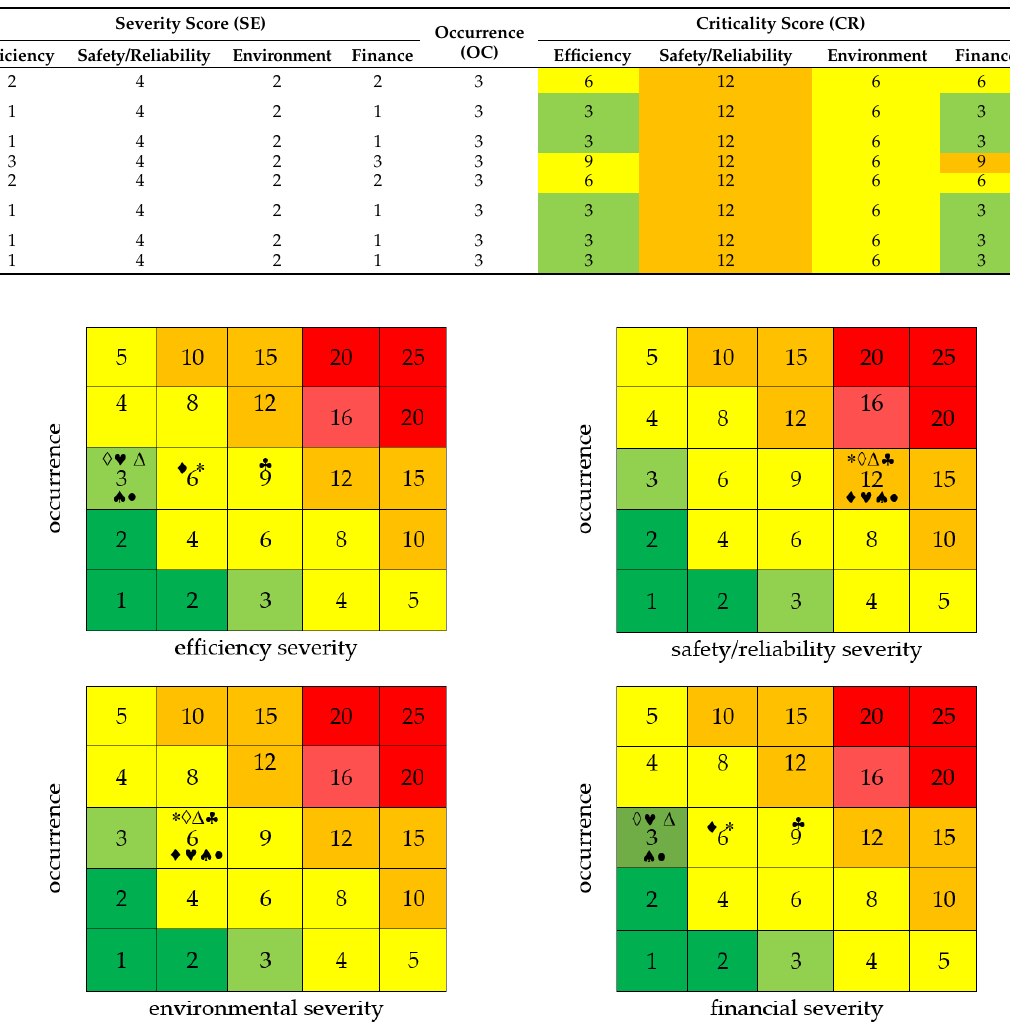
Figure 4. Criticality matrix of the sample 230 kV transmission line towers no. 1, line no. 8. Next, the severity and criticality of 20 transmission lines were determined. The criticality scores (CR) of all transmission lines were calculated and are summarized in Table 12. These scores were then plotted in criticality matrices of efficiency, environment, safety/reliability, and finance, as shown in Figure 5. The practical data of the 20 transmis- sion lines are analyzed and summarized in Table 13. Table 12. Severity and criticality analysis of the 20 transmission lines. Line